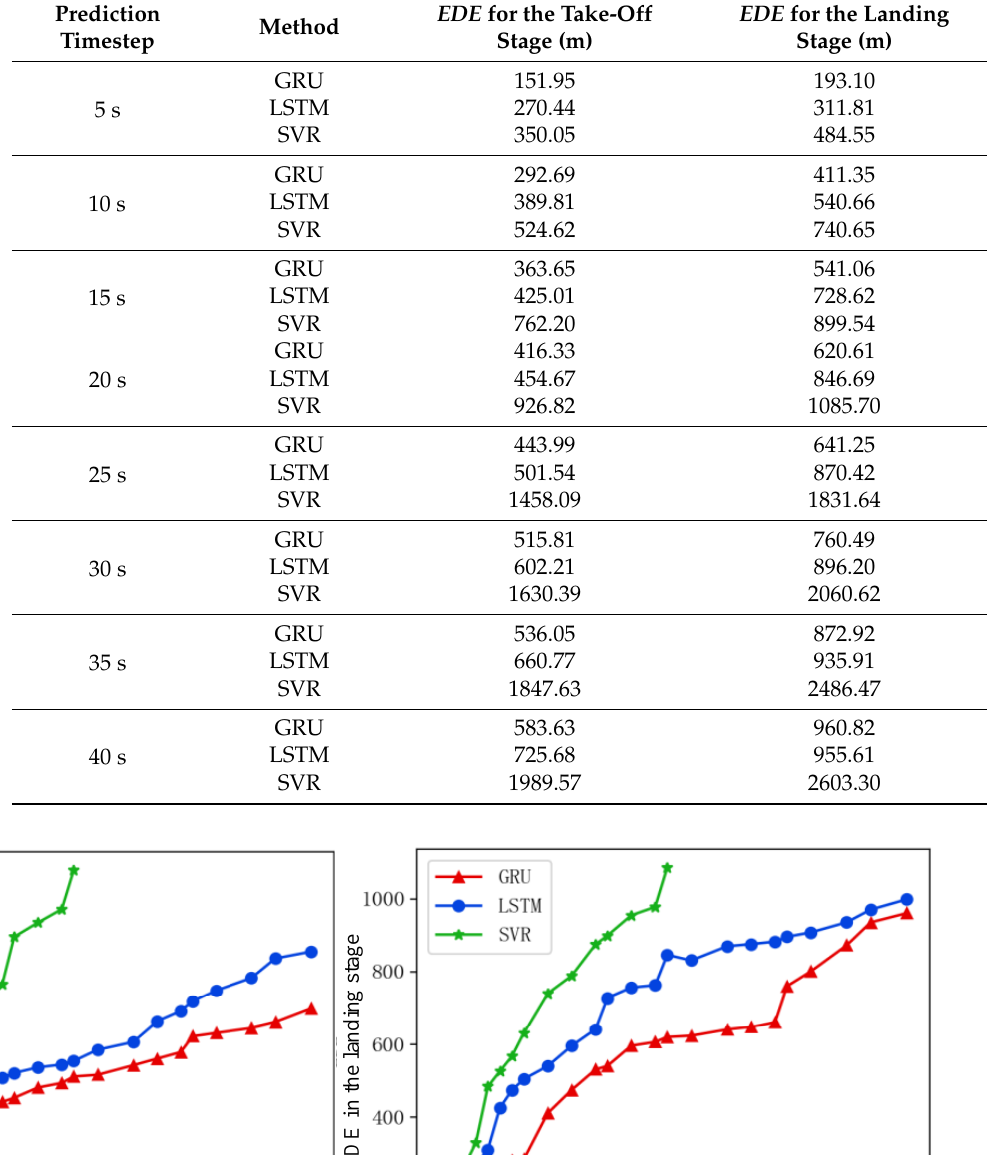
Table 4. The prediction error for manned aircraft in the take-off and landing stages.